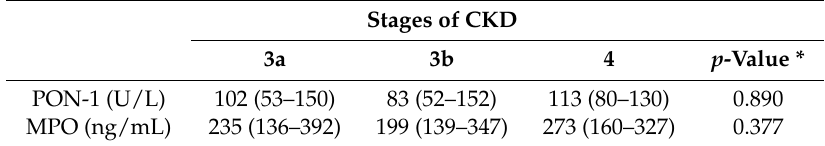
Table 4. Activity of paraoxonase-1 (PON-1) and myeloperoxidase (MPO)